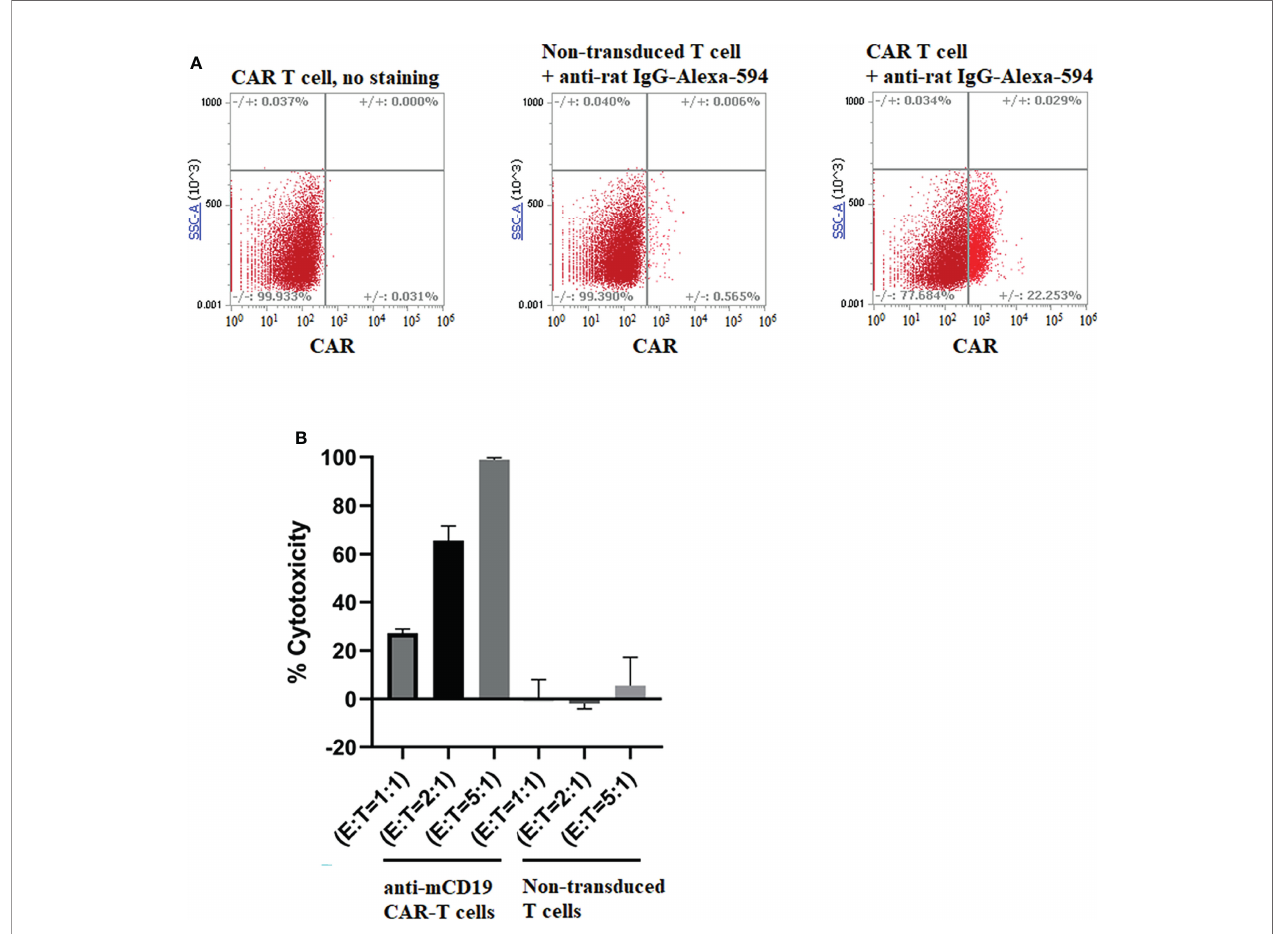
FIGURE 2 | Production of murine CAR T cells that recognize murine CD19 and analysis of their ability to kill 4T1-mCD19 cells in vitro. (A) Spleen derived T cells were transduced to express an anti-CD19 CAR and then examined for transduction ef fi ciency by fl ow cytometry using an anti-rat IgG labeled with AlexaFluor 594, as described in Methods. Data shown are representative of three separate transduction procedures. (B) Analysis of the ability of the aforementioned anti-mouse CD19 CAR T cells to kill 4T1-mCD19 cancer cells in vitro . (Effector:target cell ratio = 5:1). Bar graphs display mean ± S.D.